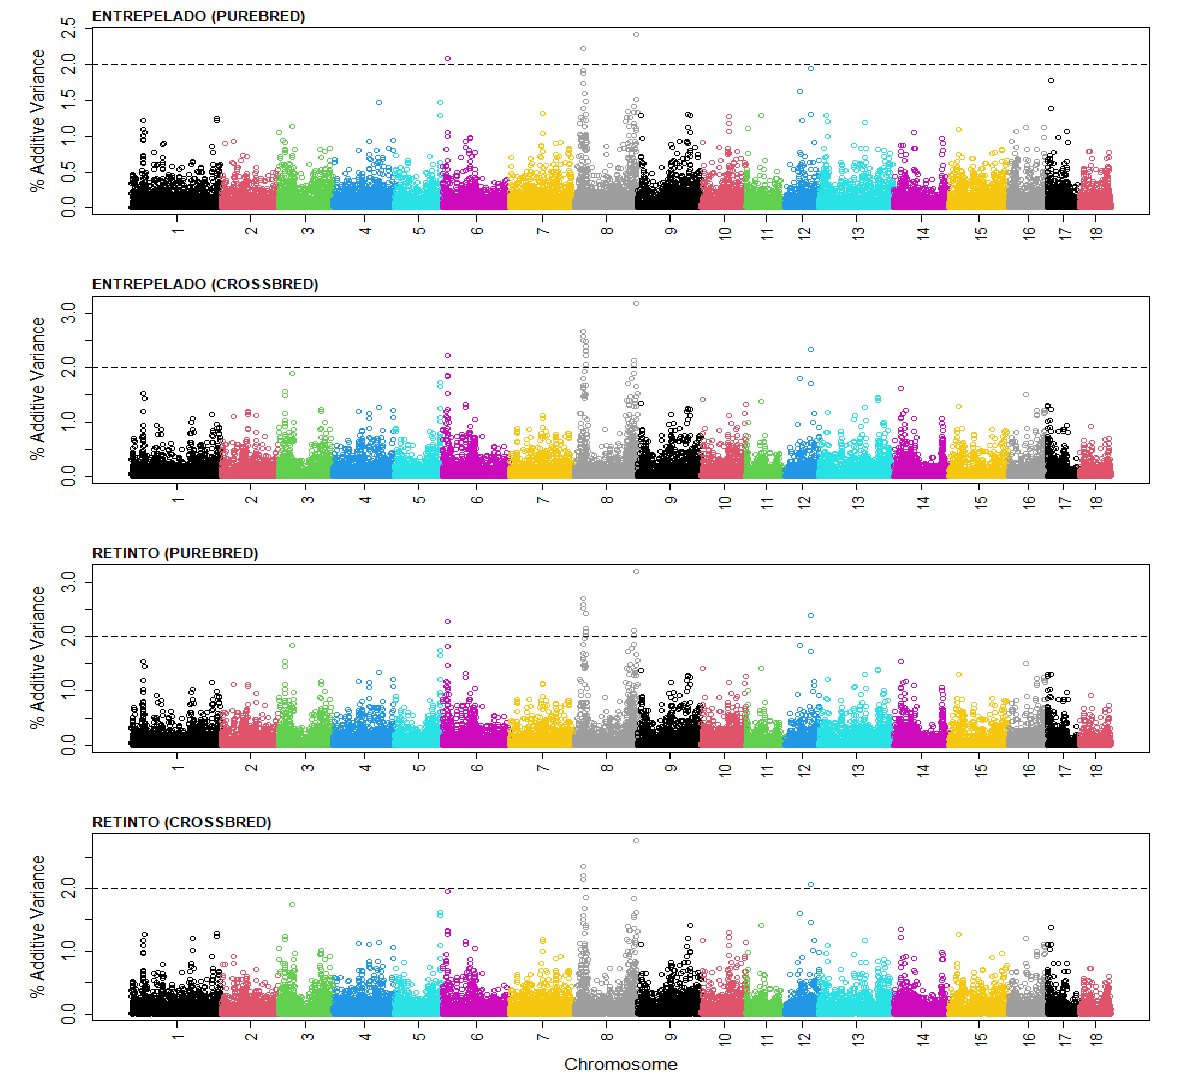
Figure 1. Distribution of the percentage of the additive genetic variance explained by genomic segments of 30 SNPs within the autosomal genome of purebred and crossbred performance for the total number born (TNB) in the Entrepelado and Retinto varieties. Black: chromosomes 1, 9 and 17; red: chromosomes 2, 10 and 18; green: chromosomes 3 and 11; deep blue: chromosomes 4 and 12; blue: chromosomes 5 and 13; purple: chromosomes 6 and 14; yellow: chromosomes 7 and 15; grey: chromosomes 8 and 16.